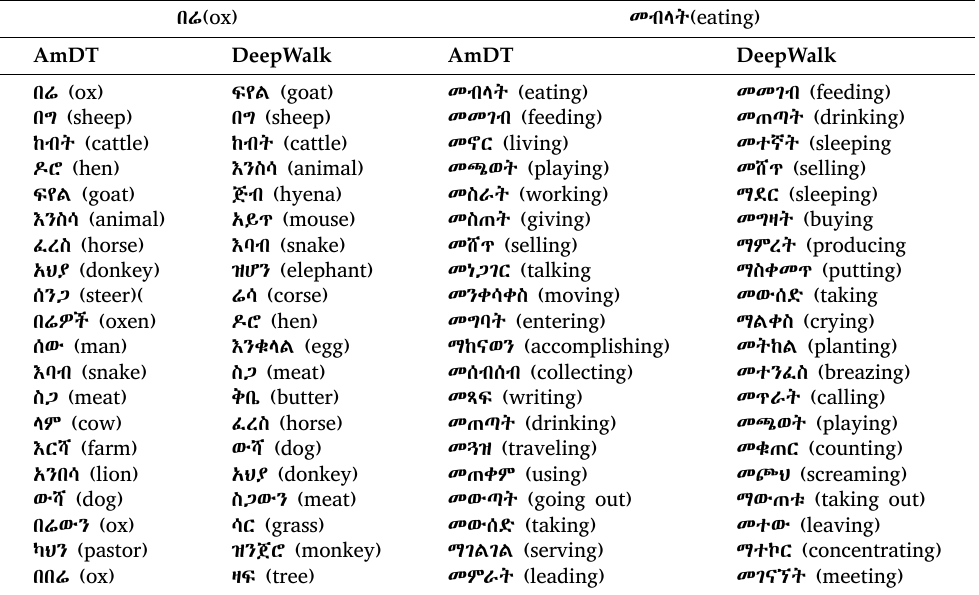
Table 9. Comparison of similar words generated from the AmDT and network embedding (Deep‑ walk)